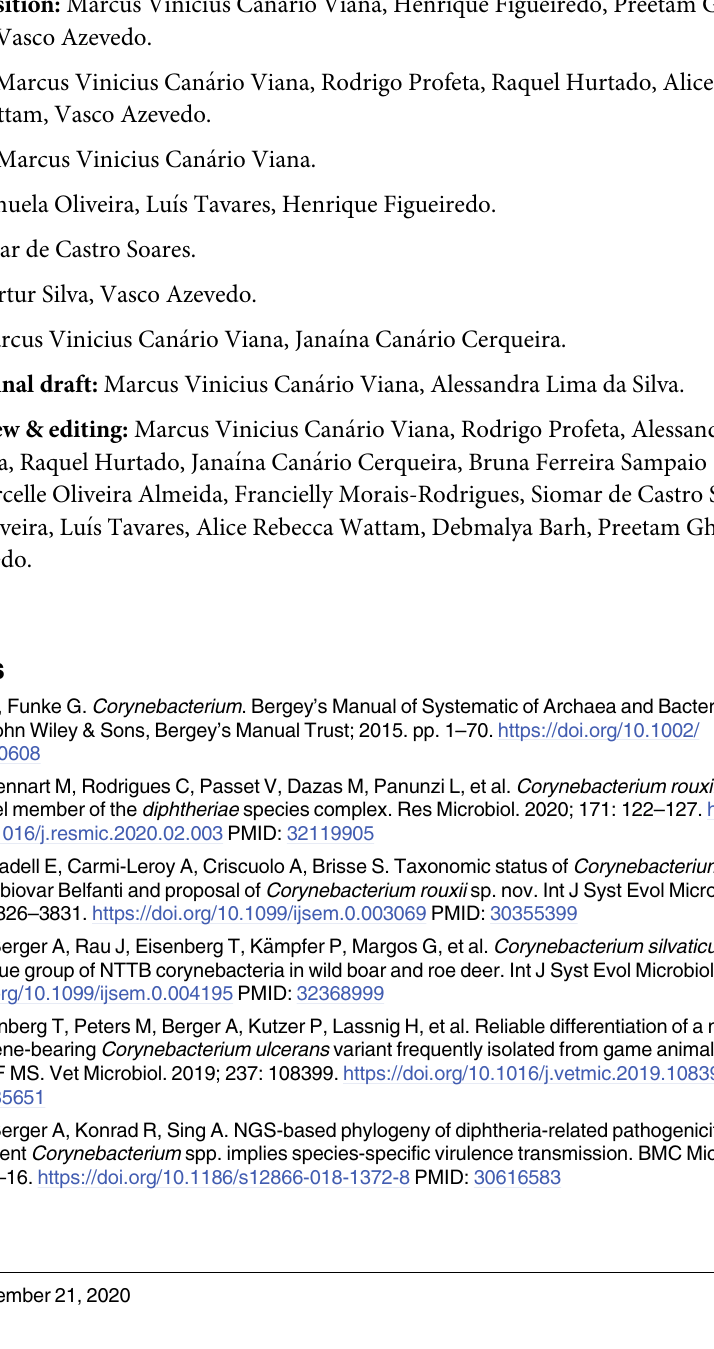
S13 File. Probability of pathogenicity for humans. PathogenFinder v. 1.1 was used to identify proteins associated to bacterial pathogens in the proteome of C . silvaticum PO100/5 (isolated from domestic pig) and KL0182 T (wild